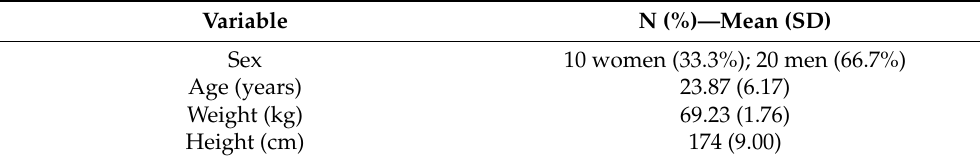
Table 1. Sample Characteristics.